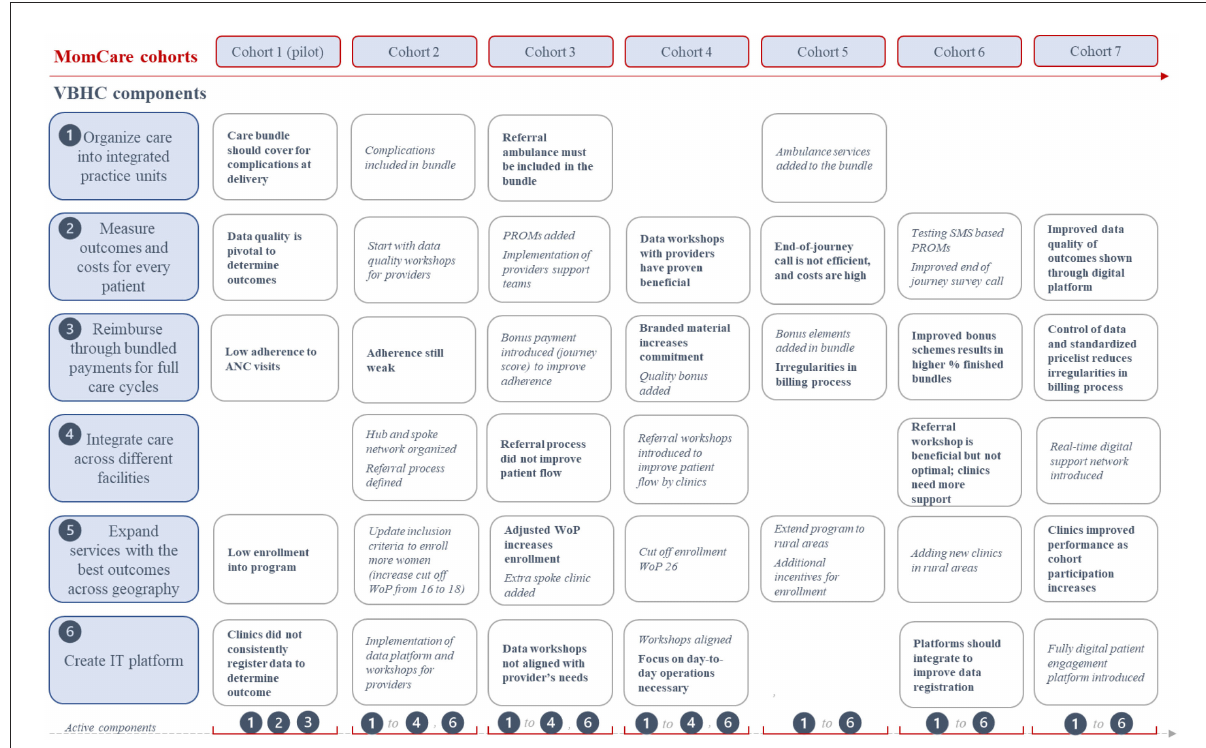
FIGURE3 Implementation of VBHC components, learnings and adaptations (learnings are shown in bold, adaptations of components are shown in